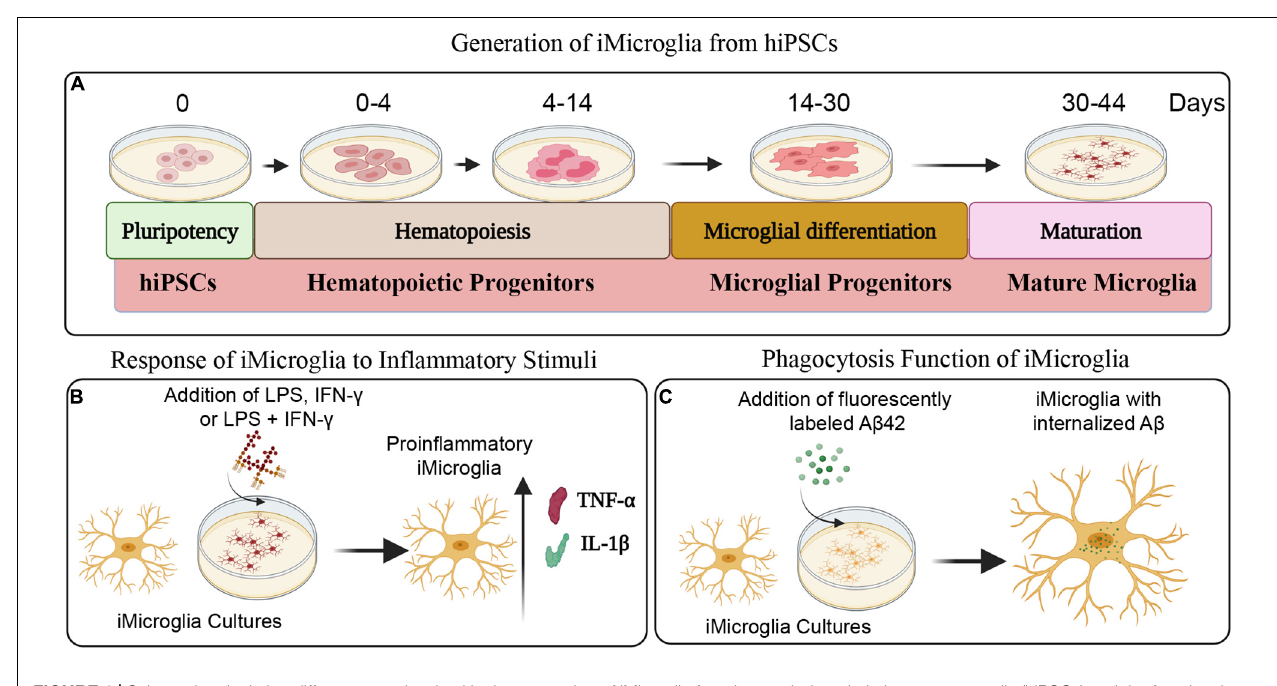
FIGURE 1 | Schematics depicting different steps involved in the generation of iMicroglia from human induced pluripotent stem cells (hiPSCs) and the functional characterization of iMicroglia using specific assays. (A) Illustrates the timeline for transforming hiPSCs into mature microglia through stages of hematopoietic progenitor cells and microglial progenitor cells. (B) Shows the design employed to generate activated iMicroglia secreting elevated levels of proinflammatory cytokines tumor necrosis factor-alpha (TNF- α ) and interleukin-1 beta (IL-1 β ), using proinflammatory stimuli such as lipopolysaccharide (LPS), interferon-gamma (IFN- γ ), or LPS + IFN- γ . (C) Depicts the experiment for demonstrating the proficiency of iMicroglia to phagocytose the fluorescently labeled amyloid-beta (A β ).